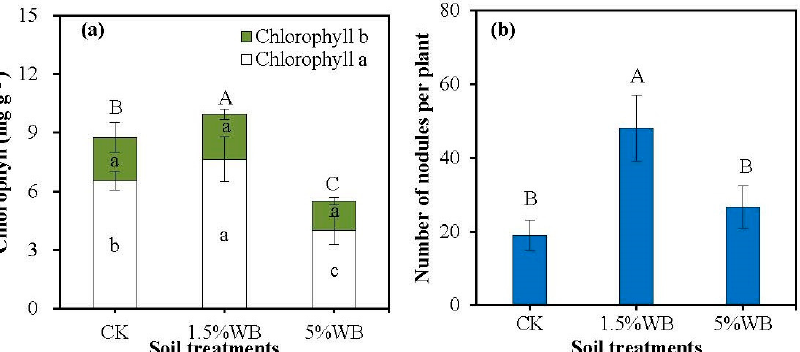
Figure 2. Effect of WB on chlorophyll a and chlorophyll b ( a ) and the number of nodules per